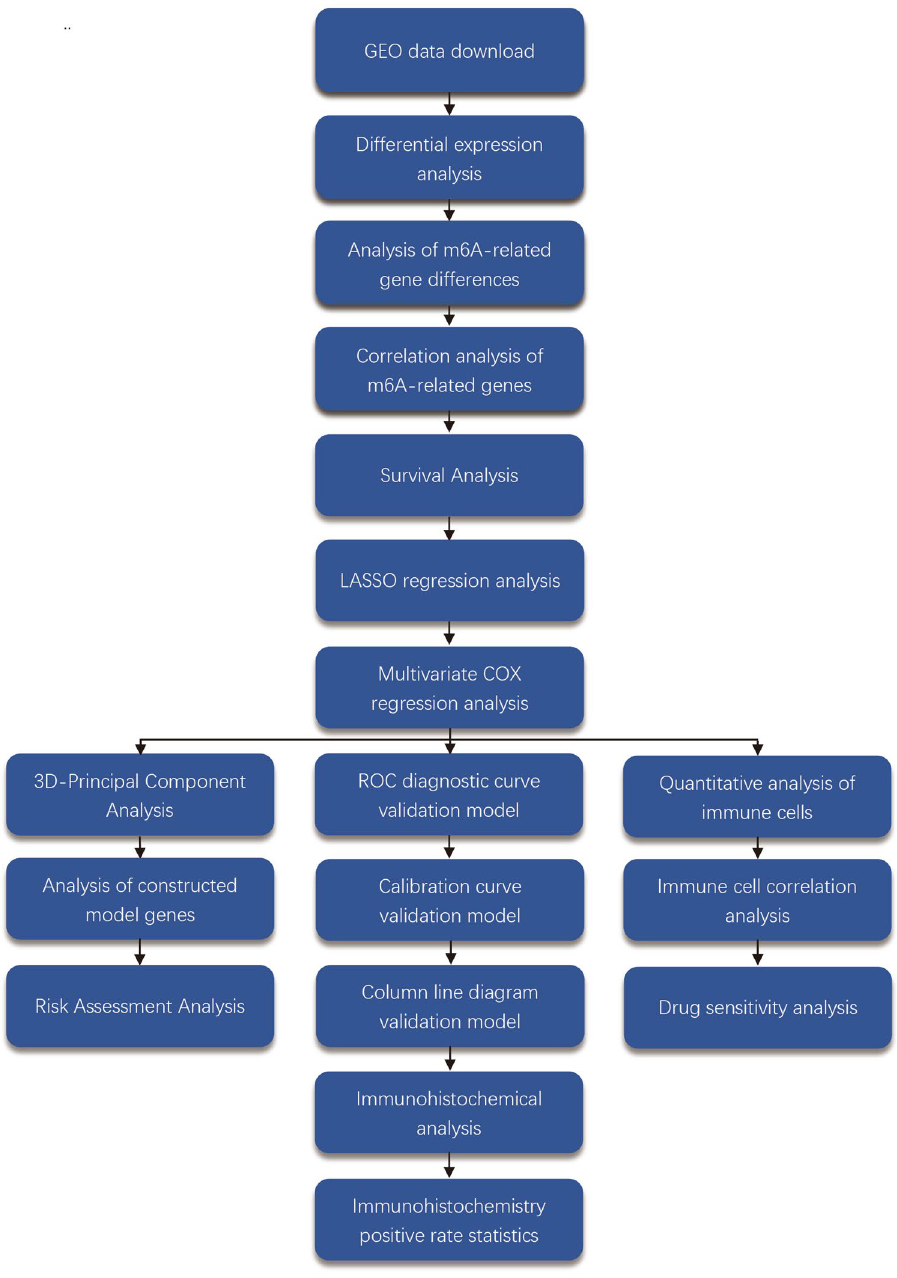
Figure 1. Workflow diagram. From the diagram, we can see the flow of our work clearly and